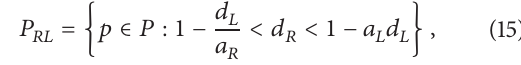
̃𝑓 for 𝑎 𝐿 = 0.5 , 𝑎 𝑅 = 1.2 ,